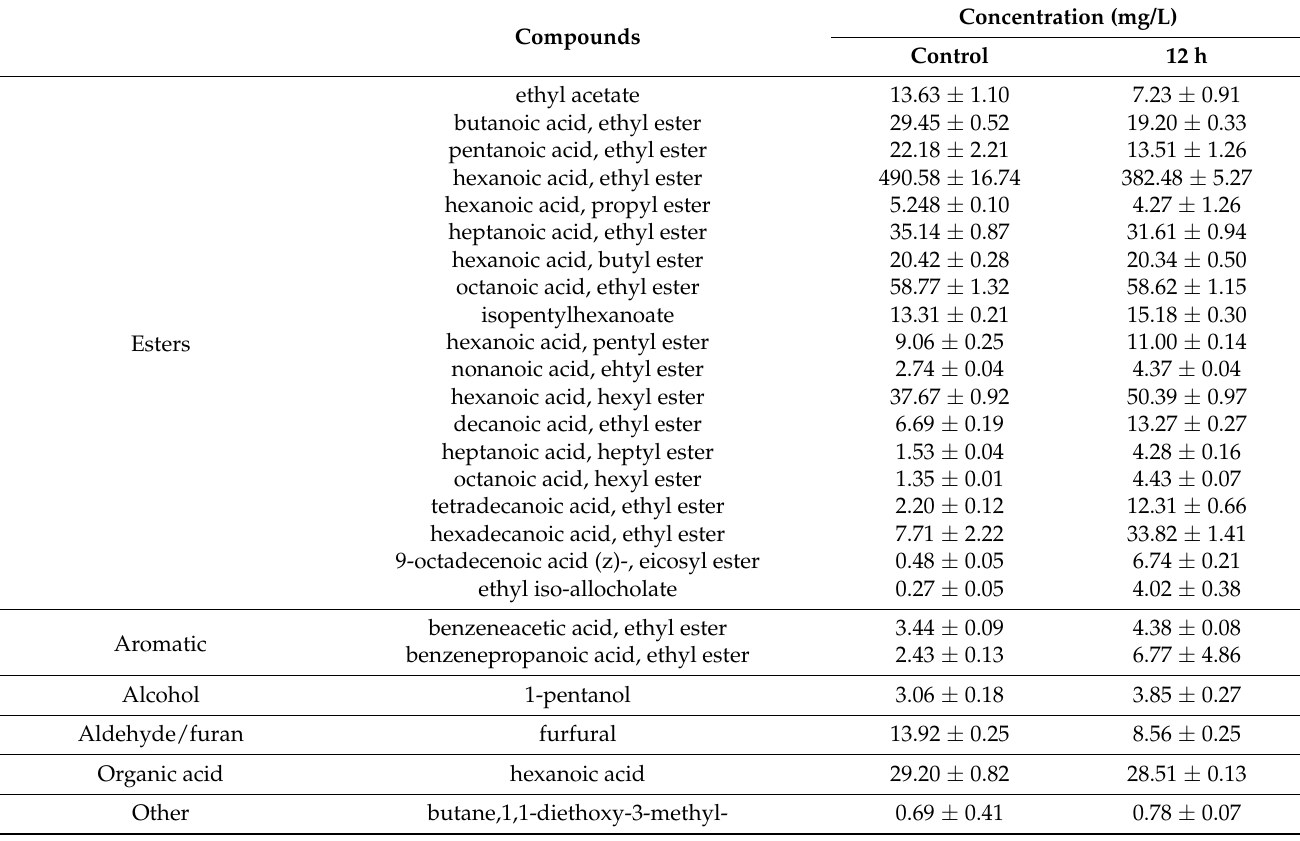
Table 3. Volatile organic compounds untreated and treated for 12 h in Chinese liquor.